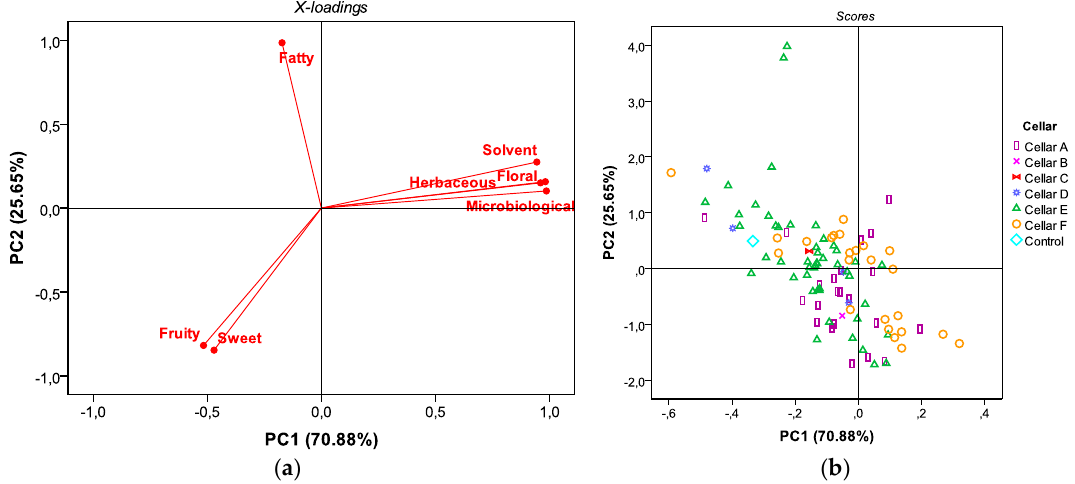
Figure 3. Results of the principal component analysis carried out on the aromatic series matrix: ( a ) loadings of the variables on the first and second principal components; ( b ) scores of the % OAV on each sensory descriptor adding up the different strains by cellar of origin in the plane formed by the first and second principal components. Values are the mean of two % OAV ratios.